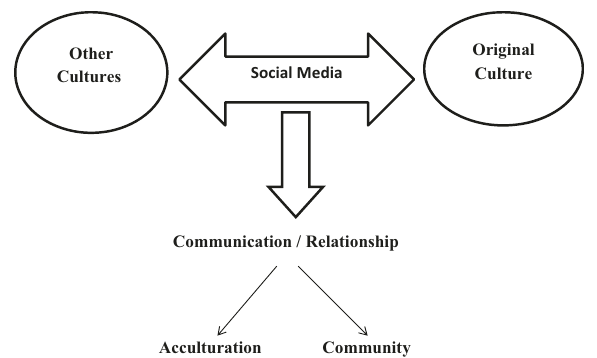
Fig. 1 A paradigm of social media effect on cultural identity. This fi gure represents the full structural model to demonstrate the potential relationships among the concepts of communication/relationship, acculturation, and community, in which social media connects people, and through social media utilizing, connections are increased, which aids individuals to avoid acculturation process effects and establish a sense